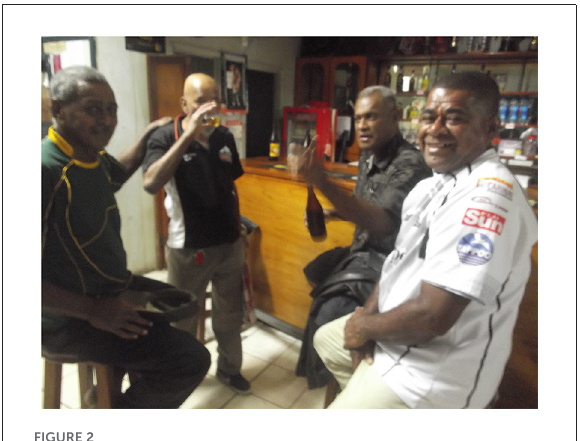
FIGURE2 Barman accepts drink from Henry, Ba, 20 June